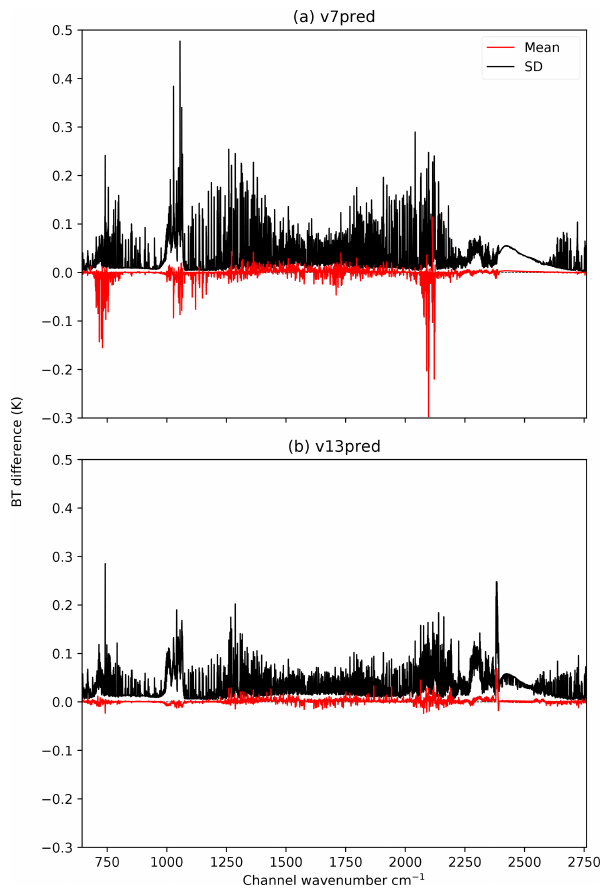
Figure 2. RTTOV vs. brightness temperatures calculated from channel-integrated LBL transmittances for IASI (a) v7 and (b) v13 predictors with variable O 3 for the 83 training profiles.